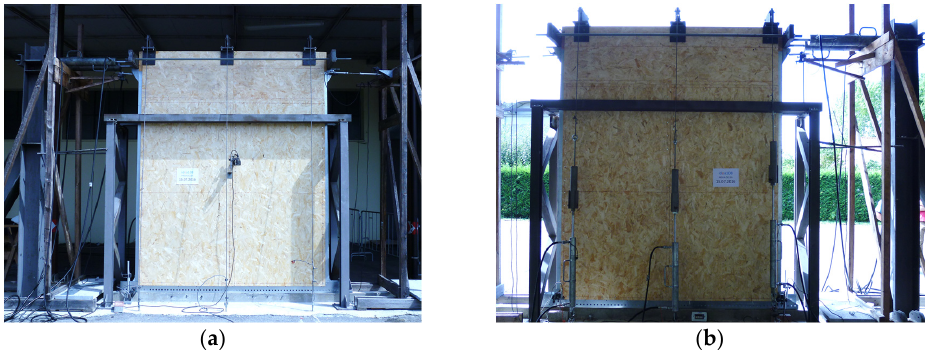
Figure 7. Photos of the specimen before the test: ( a ) front view; ( b ) back view.